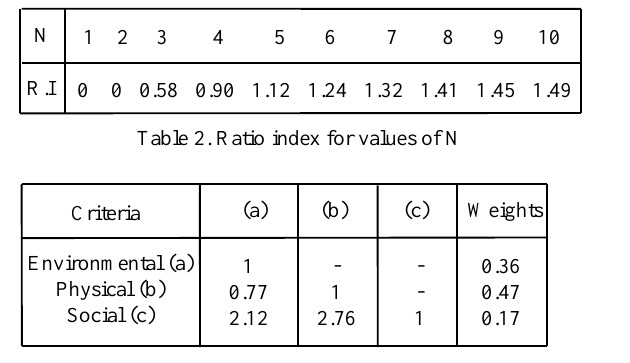
Table 3. Comparative matrix of the criteria used in the study and the obtained weights.